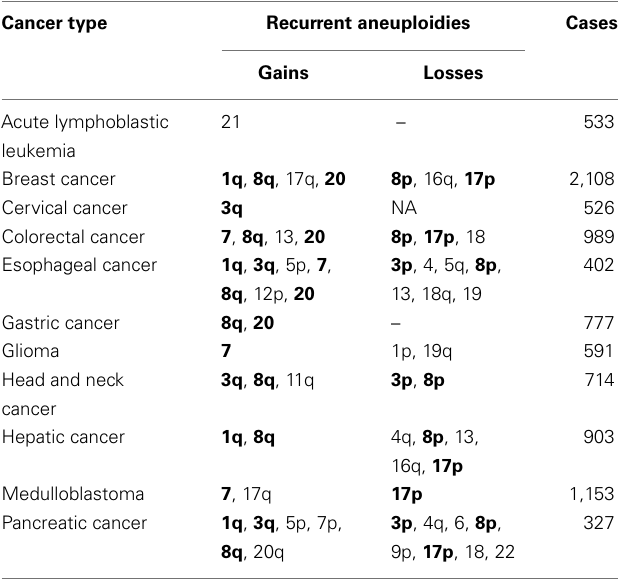
Table 1 | Recurrent aneuploidies in cancers from different